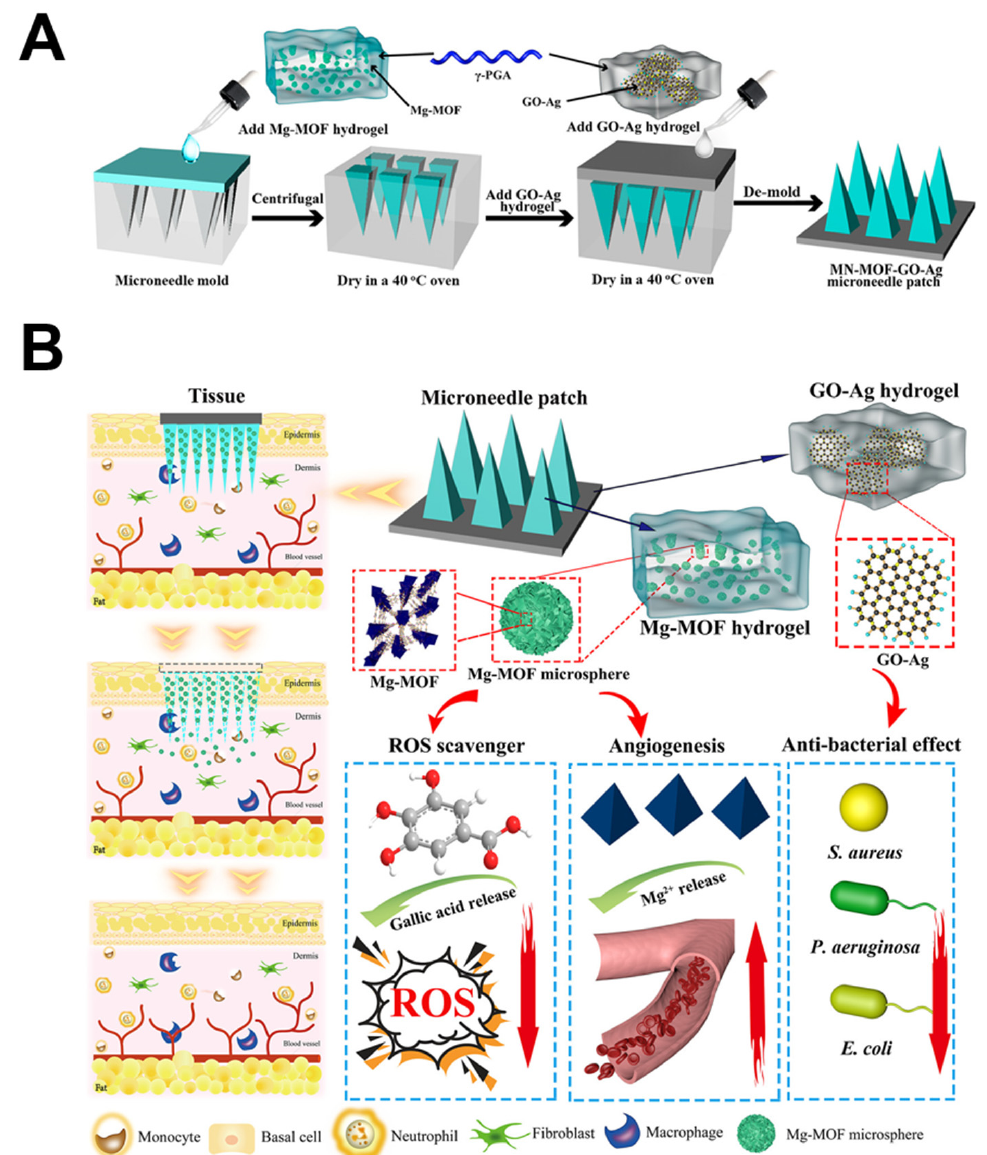
Figure 9. ( A ): Schematic for the MN-MOF-GO-Ag synthesis. ( B ): Illustration of the magnesium organic framework-based MN Patch (Denoted as MN-MOF-GO-Ag) for the accelerated diabetic wound healing. Reproduced with permission from [128].